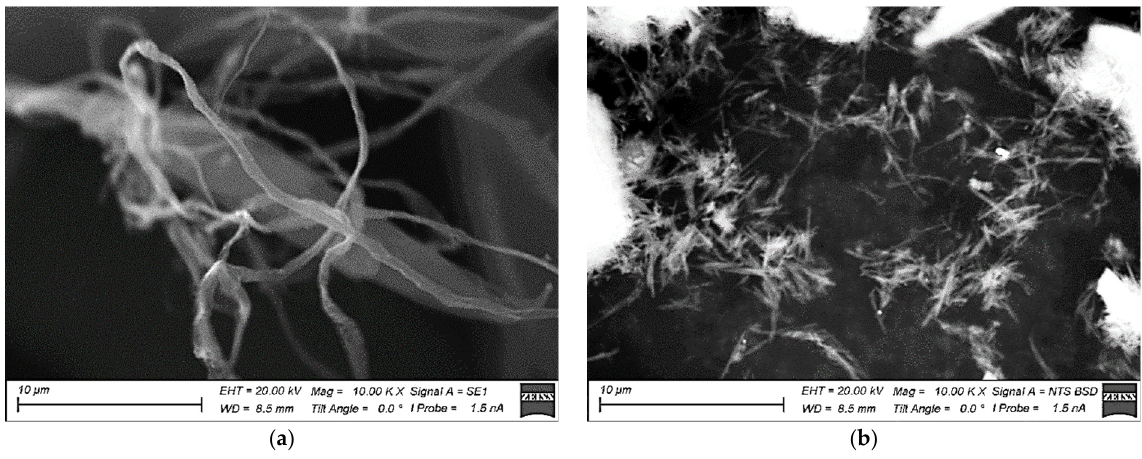
Figure 1. SEM micrographs of CNTs ( a ) and HNTs ( b ).